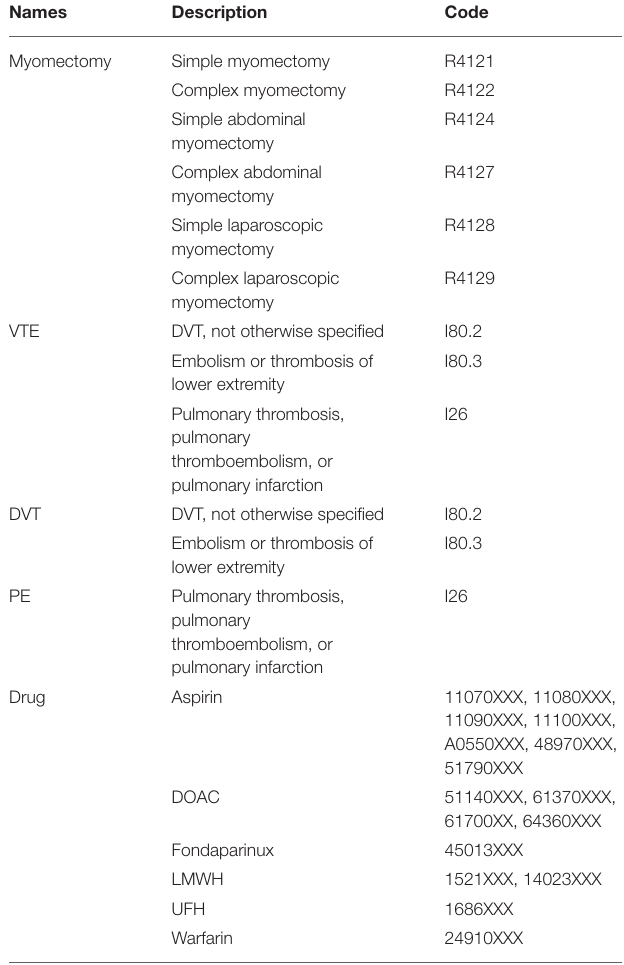
TABLE 1 | Diagnostic and procedural codes used in this